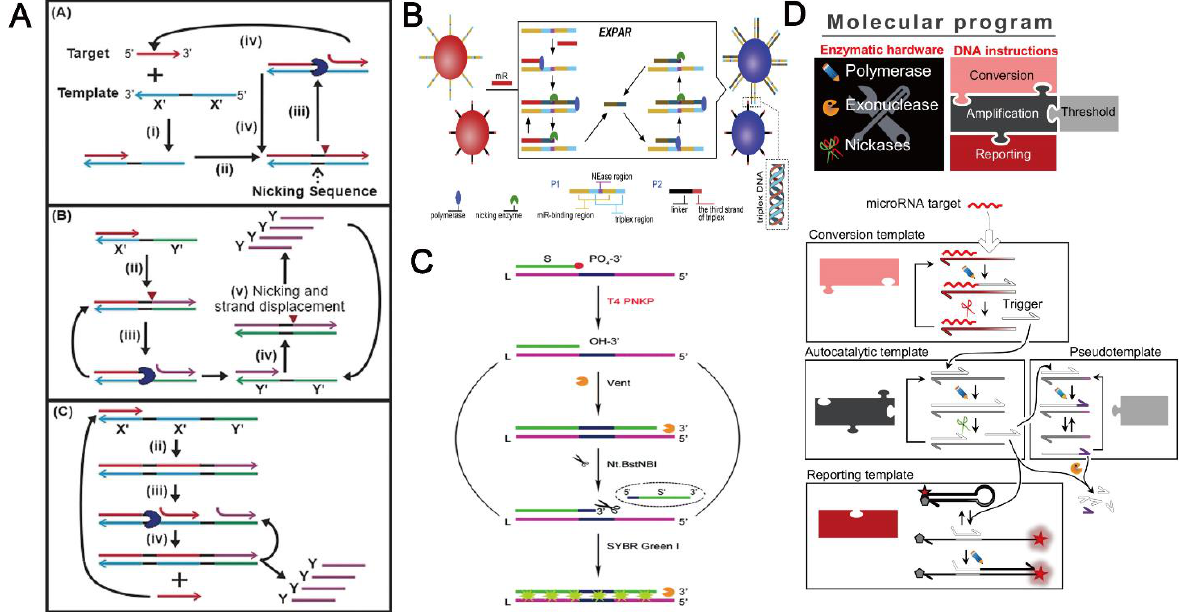
Figure 2. ( A ) Basic principle of EXPAR. From top to bottom: one-template EXPAR system, two-